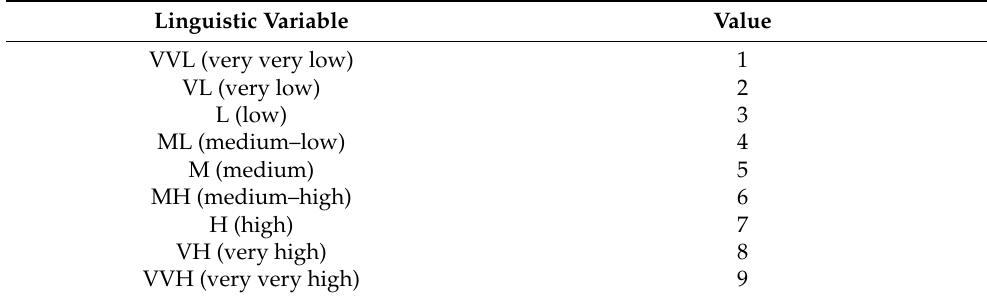
Table 2. Linguistic variables and their corresponding values